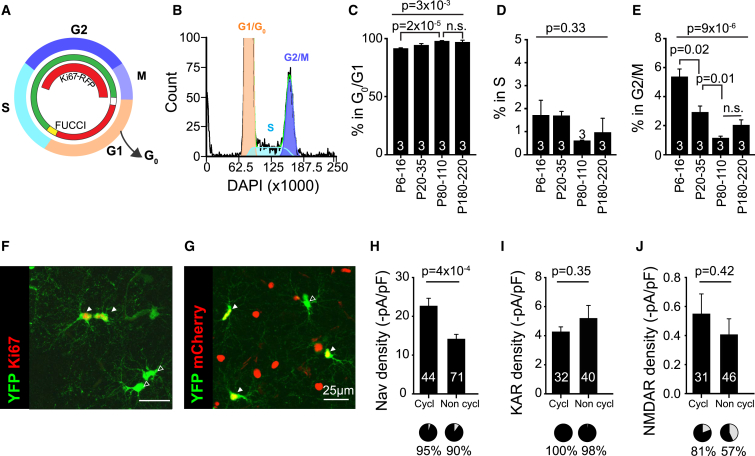
OPC Cell-Cycle Changes with Age and NaV Channel density(A) Schematic diagram showing the fluorescent labeling seen at different points in the cell cycle for fluorescent ubiquitination-based cell-cycle indicator (FUCCI) and Ki67-RFP mice.(B) Representative image of flow cytometry analysis of relative DAPI intensity in OPCs, with the color coding of peaks representing different cell cycle stages.(C–E) The percentage of OPCs in G0/G1 (C), S phase (D), and G2/M phase (E) as measured by flow cytometry. Numbers on graphs represent the number of animals used per time point.(F) Ki67-RFP:NG2-EYFP cortical section showing yellow fluorescent protein (YFP)-positive (green) OPCs with (white arrowheads, in S/G2/M) and without (black filled arrowheads, in G0/G1) Ki67 (red) expression. Scale bar, 25 μm.(G) FUCCI:NG2-EYFP cortical section showing YFP+ OPCs with (white arrowheads, in G0/G1) and without (black filled arrowheads, in S/G2/M) mCherry labeling. Scale bar, 25 μm.(H) NaV densities were significantly higher in cycling OPCs compared with non-cycling (cycl, cycling [in S/G2/M]; non cycl, non-cycling [in G0/G1]), whereas the proportion of OPCs with detectable currents did not change (pie chart, p = 0.50, χ2).(I and J) Neither (I) KAR nor (J) NMDA densities differed between cycling and non-cycling OPCs, nor did the proportions of cells responding (pie charts; KAR, p = 0.86; NMDAR, p = 0.051; χ2).Numbers on graphs represent the number of cell recorded from 18 animals. The p values are from Student’s t tests (H–J) or one-way ANOVA (C–E, top), followed by Holm-Bonferroni post hoc test (bottom). Data are shown ± SEM.